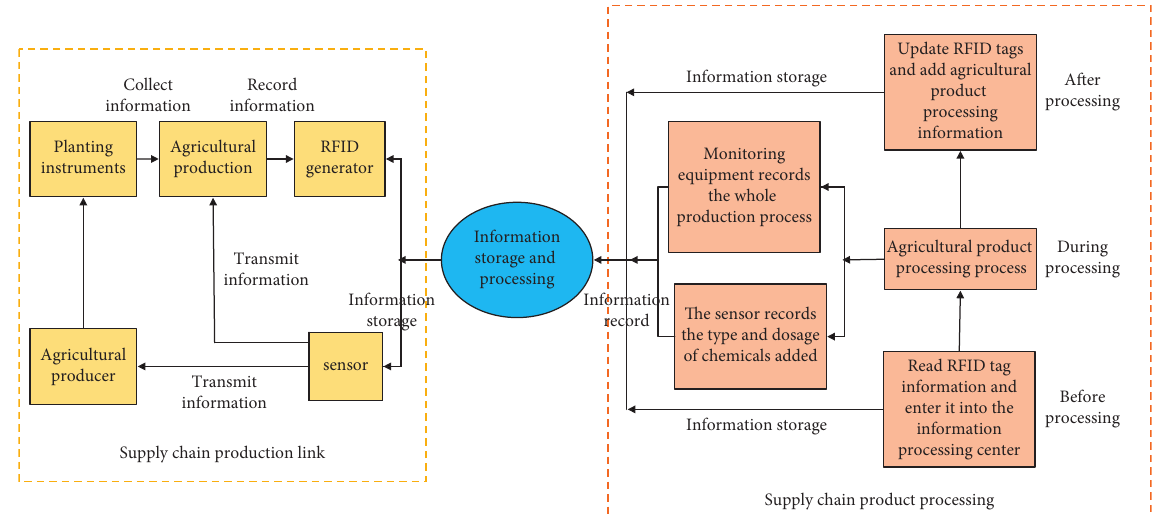
Figure 2: Production and processing of agricultural products in the rural economic supply chain based on Internet of Things technology.